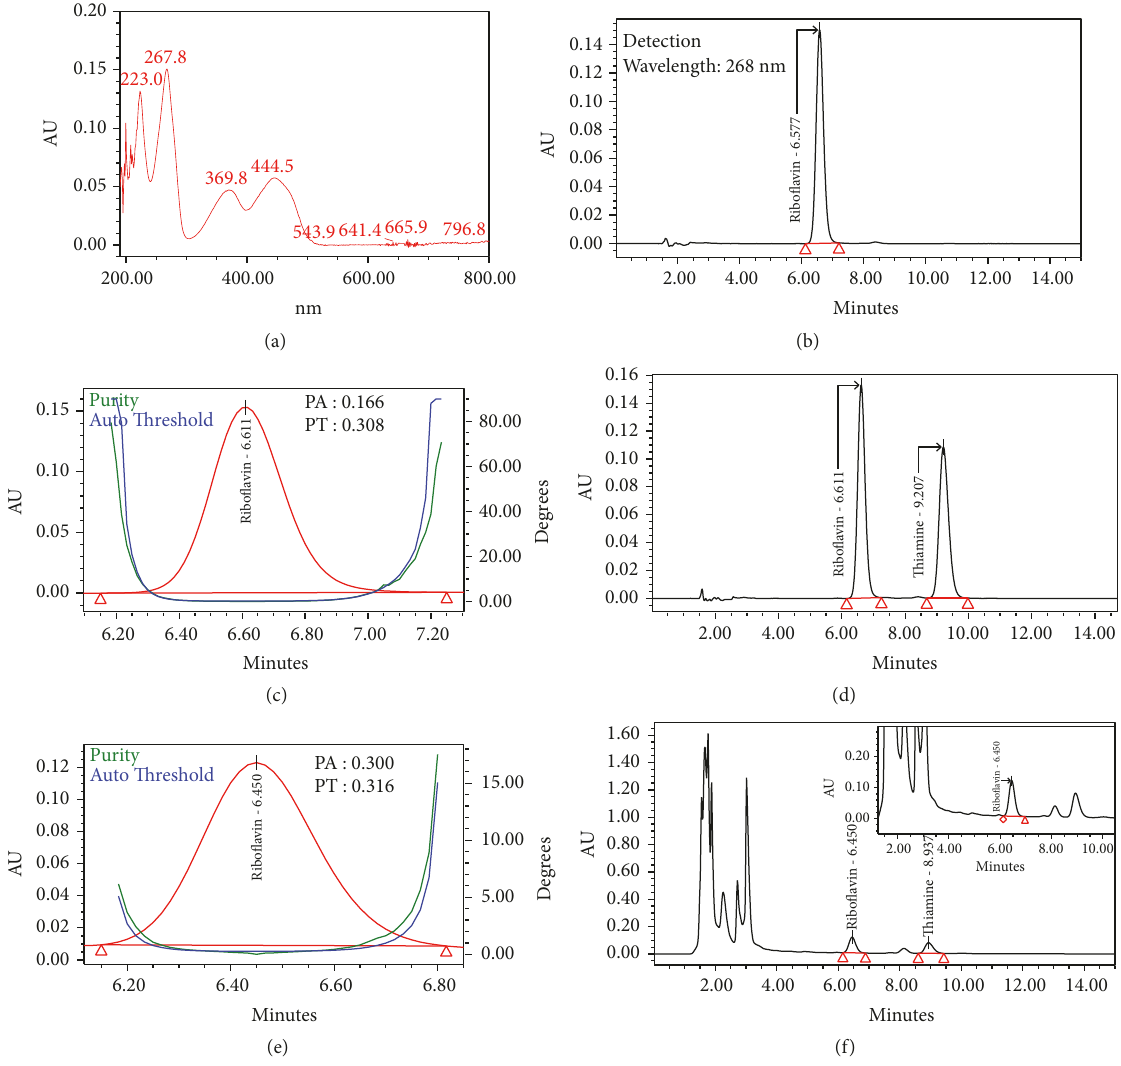
Figure 3: HPLC chromatograms obtained in peak identification and spectral analysis of riboflavin (B2) using photodiode array detector (PDA,2996-Waters):(a)absorbance spectra of B2 from 190nm to800nm, (b) referencestandard, (c)purity plot of the B2 in standard solution, (d) reference standards solution, (e) purity plot of the B2 in test sample spiked with reference standards, and (f) test sample spiked with reference